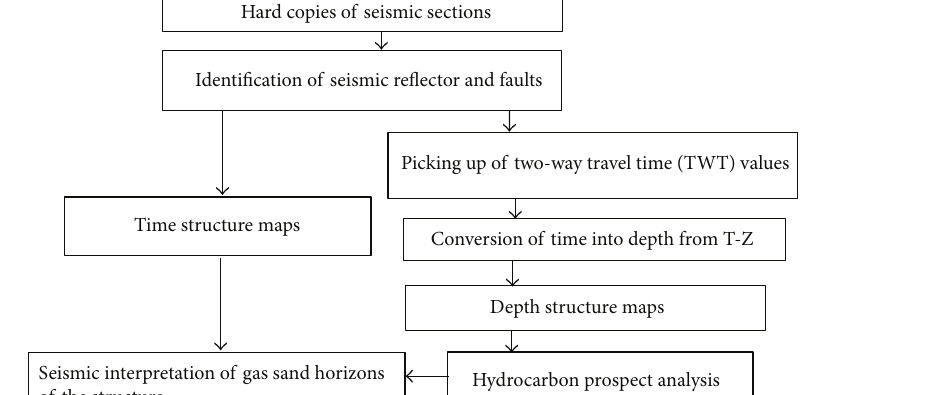
Figure 2: Flow chart for the seismic interpretation of gas sand horizons of the Rashidpur structure.